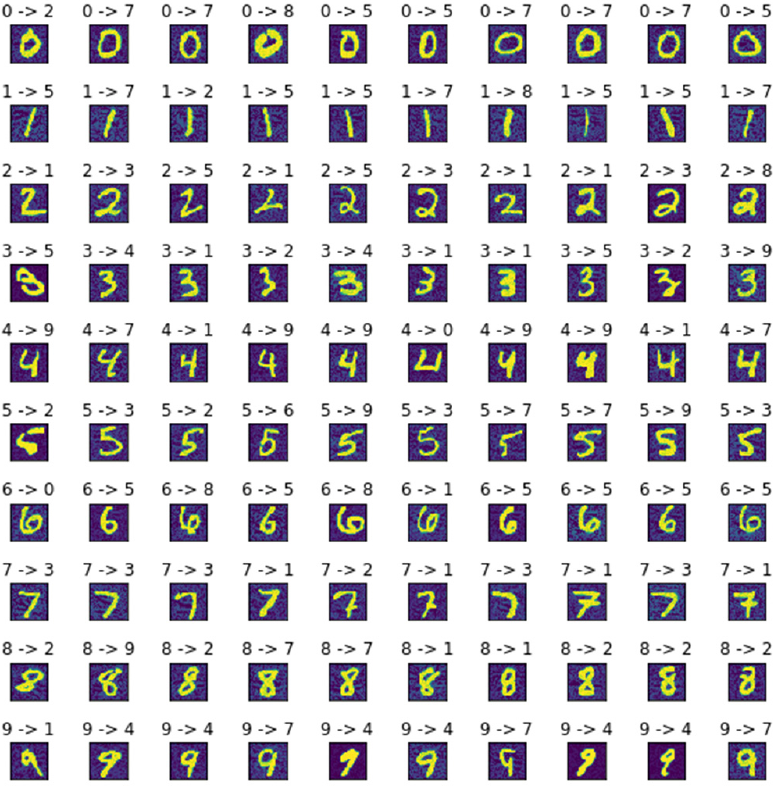
Figure 8. The adversarial examples of SAGM for Cifar10.